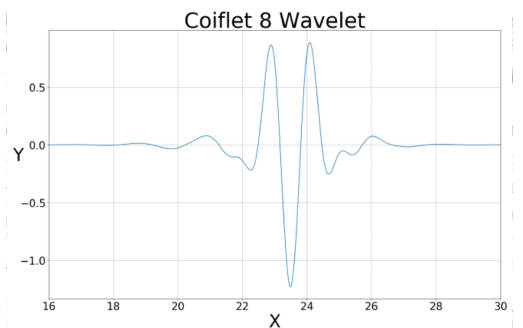
Figure 7. The Coiflet 8 wavelet applied in this paper. It exhibits a similar structure to the meter data, making it a suitable candidate for the wavelet transformation of the input data.